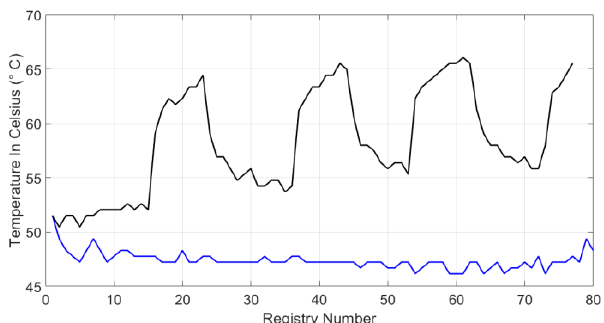
Figure 11. Hardware system temperature for test 2.